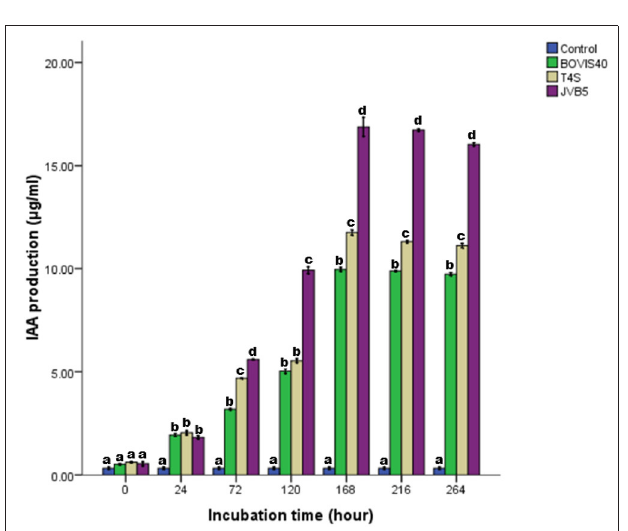
FIGURE 4 | Qualitative screening of endophytic bacteria for indole acetic acid production. Bacterial isolate codes are represented in Table 2 and different alphabets indicate significant differences in triplicate readings. SFR35, B. cereus ; FTL29, B. wiedmannii ; CAL14, Bacillus sp.; T4S , B. cereus ; BS27, P. lini ; BOVIS40, S. indicatrix ; JVB5, S. maltophilia ; TSN29, B. albus ; BLBS20, B. cereus ; SFL02, B. thuringiensis ; PK60, S. maltophilia, VS52, B. subtilis, BAAG44, B. thuringiensis, SFS19, B. pseudomycoides, OLT2020, B. toyonensis, BSA123, B. thuringiensis, LS11, B. paramycoides, J4R , Pseud. saponiphilia ; VEJU7080, B. cereus ; FOBS21, Pseudomonas sp.